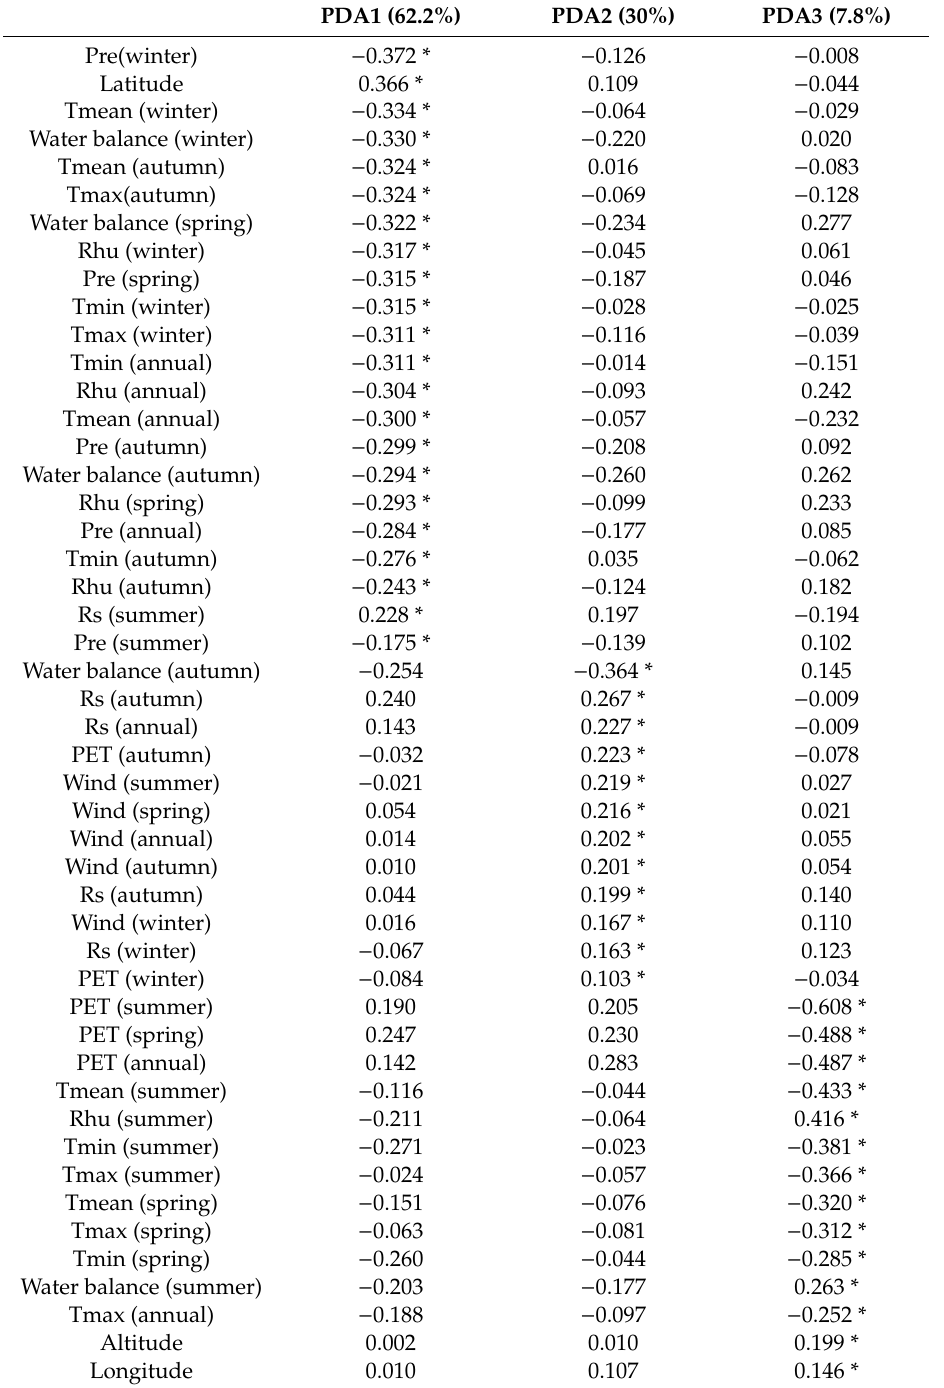
Table 3. Structure matrix of the three PDA functions for winter wheat (the explained variance by each function is indicated in parentheses; the greater the variance is, the stronger the explanatory power of the discriminant function owns.). The correlation values computed for every environmental factor are displayed as